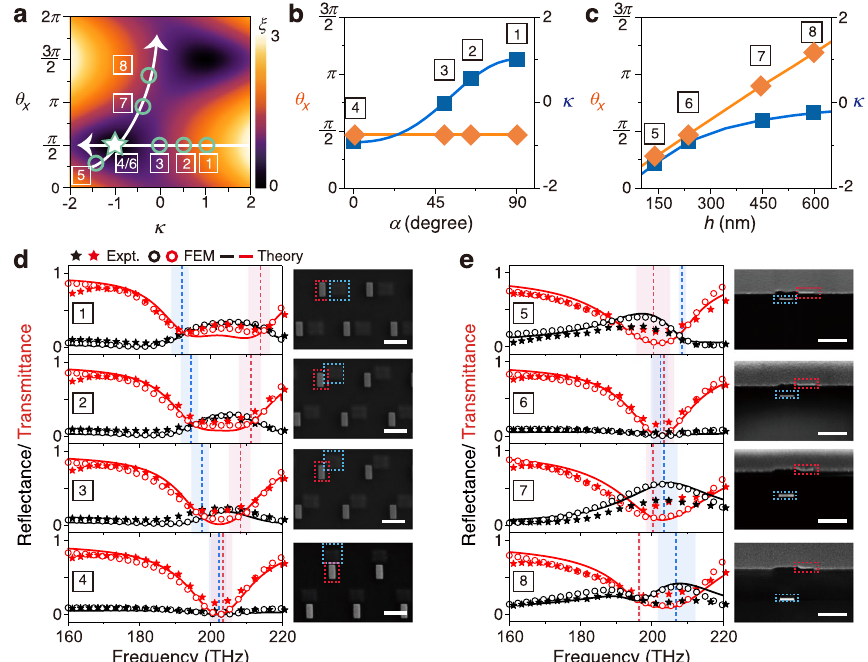
Fig. 5 Experimental characterizations on two series of metasurfaces with varying NF and FF couplings. a Calculated value of ξ | X iκ | (color map) versus κ and θ X , with points labeled with #1–8 representing = − those shown in Fig. 4d-e. b - c LEM-calculated κ and θ X for two series of samples. d Spectra of reflectance/ transmittance of samples #1–4 with top-view SEM pictures (scale bars: 500 nm) shown in the right panel, obtained by experiments (stars), simulations (circles) and CMT calculations (solid lines) with parameters computed by the LEM theory, respectively. Here the bumps in d marked by blue dotted lines are SiO 2 bumps stemming from the deposition process corresponding to the location of the bottom resonators. e Spectra of reflectance/transmittance of samples #5–8 with side-view FIB-SEM pictures (scale bars: 500 nm) shown in the right panel, obtained by experiments (stars), simulations (circles) and CMT calculations (solid lines) with parameters computed by the LEM theory, respectively. Dotted lines and shaded areas in d - e represent the resonance frequencies and radiation damping of the hybrid modes calculated with the LEM theory, respectively, while the dotted-line rectangles in the sample images denote the positions of two bars. Here, κ and X are scaled by √ Ŵ 1 r Ŵ 2